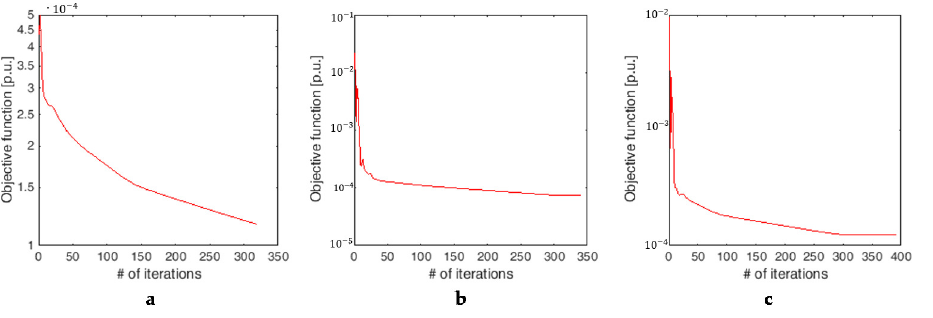
Figure 11. Objective function of the Decentralized APP for the partition in four VCZs: ( a ) Case 1 , ( b ) Case 2 , ( c ) Case 3 .